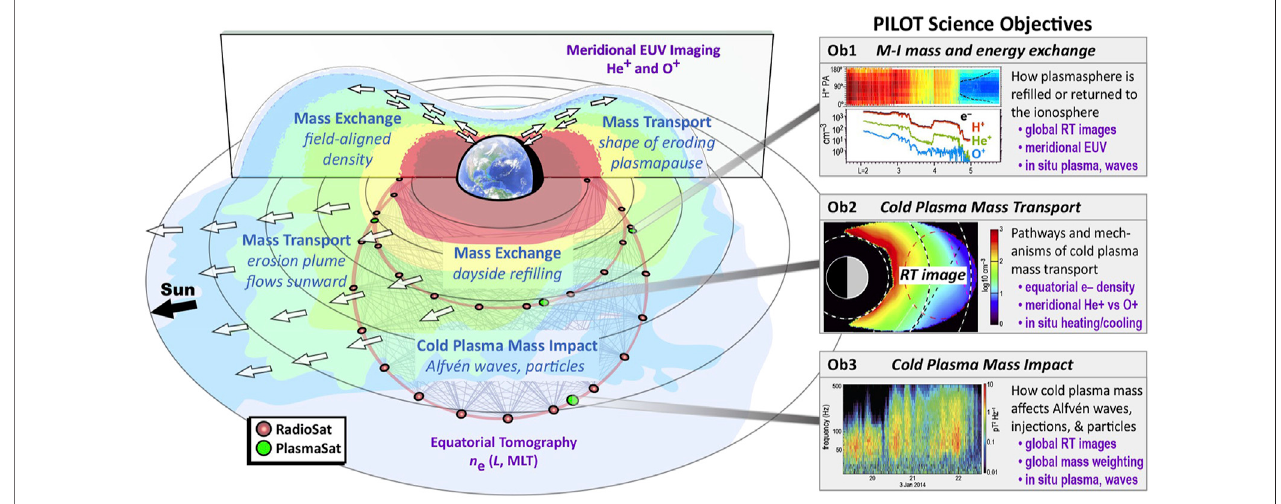
FIGURE 1 | Overview of PILOT science objectives and high-level measurement strategy. Black solid lines indicate radial distance (1 Earth radius intervals) in the equatorial plane. The light red solid lines show the two orbital paths of PILOT spacecraft. See text for details. The sub- fi gure illustrating objective 1 is adapted from Figure 3 in Goldstein et al. (2019). The sub- fi gure illustrating objective 3 is adapted from Figure 1 in Breneman et al.